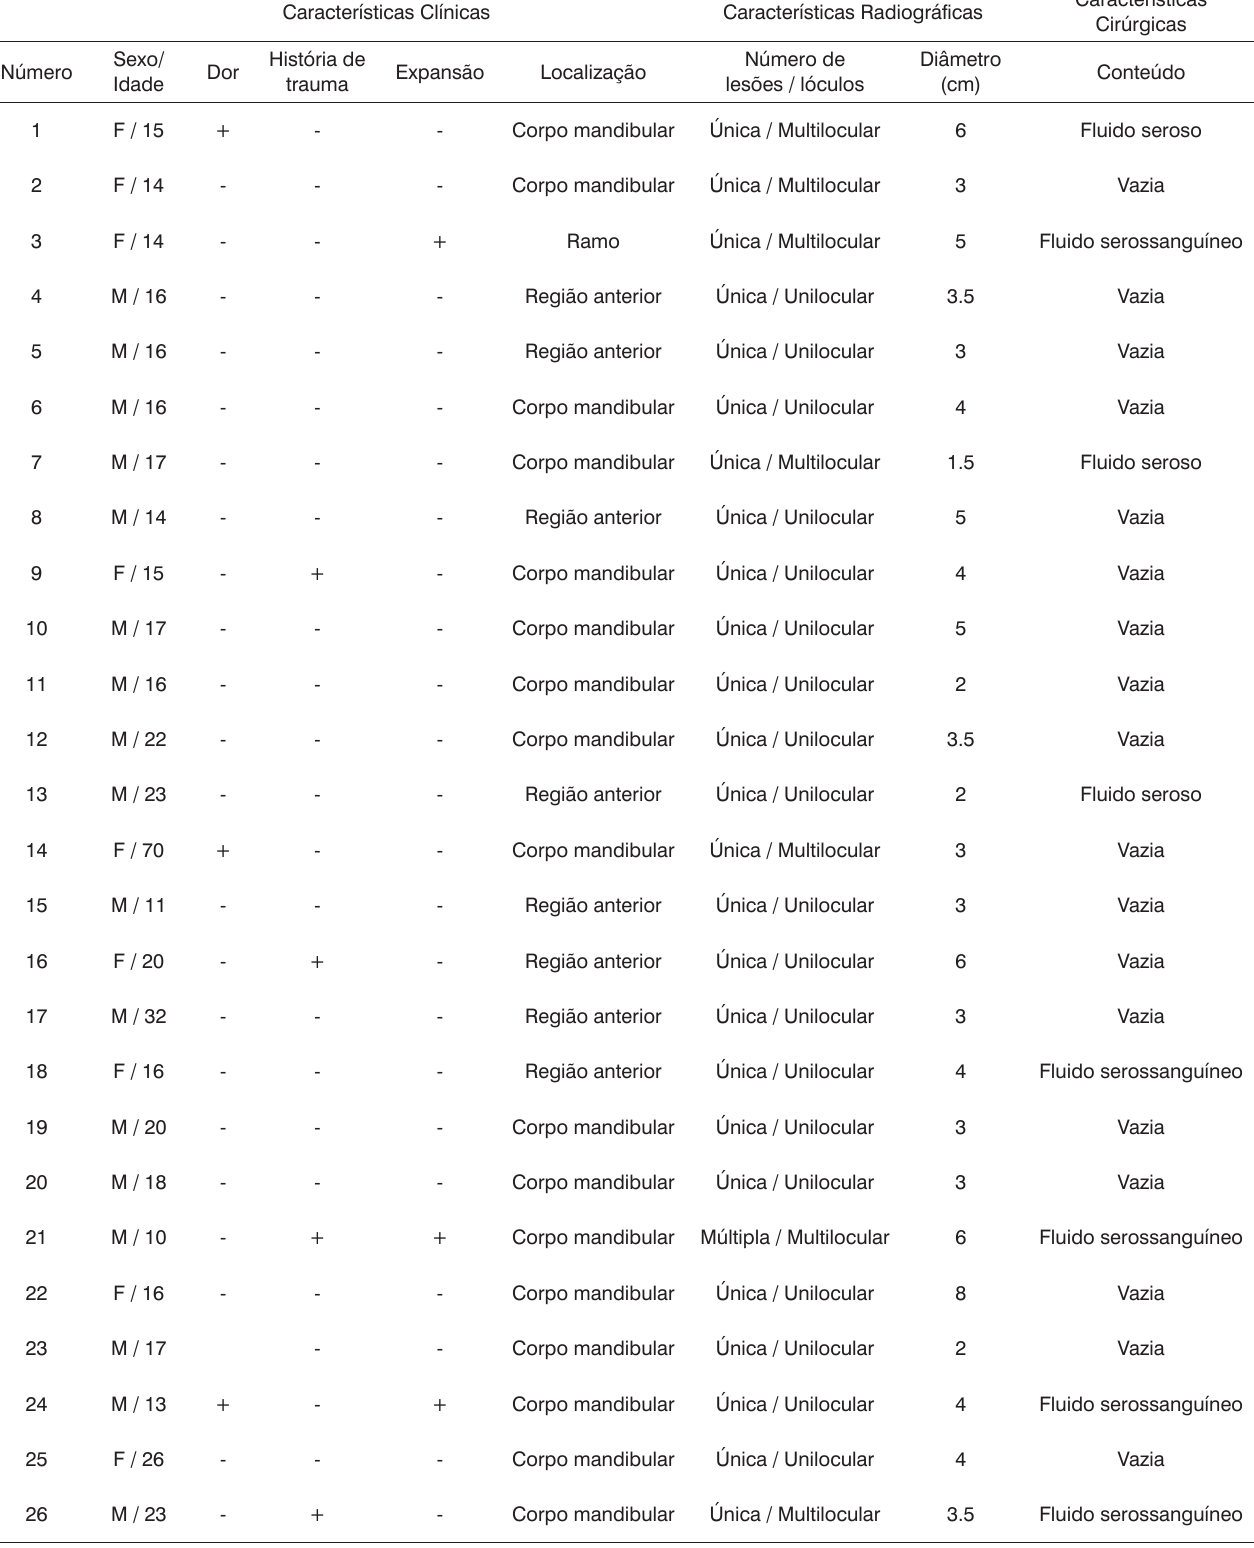
Tabela 2. Vinte e seis casos de COT: características clínicas, radiográficas e